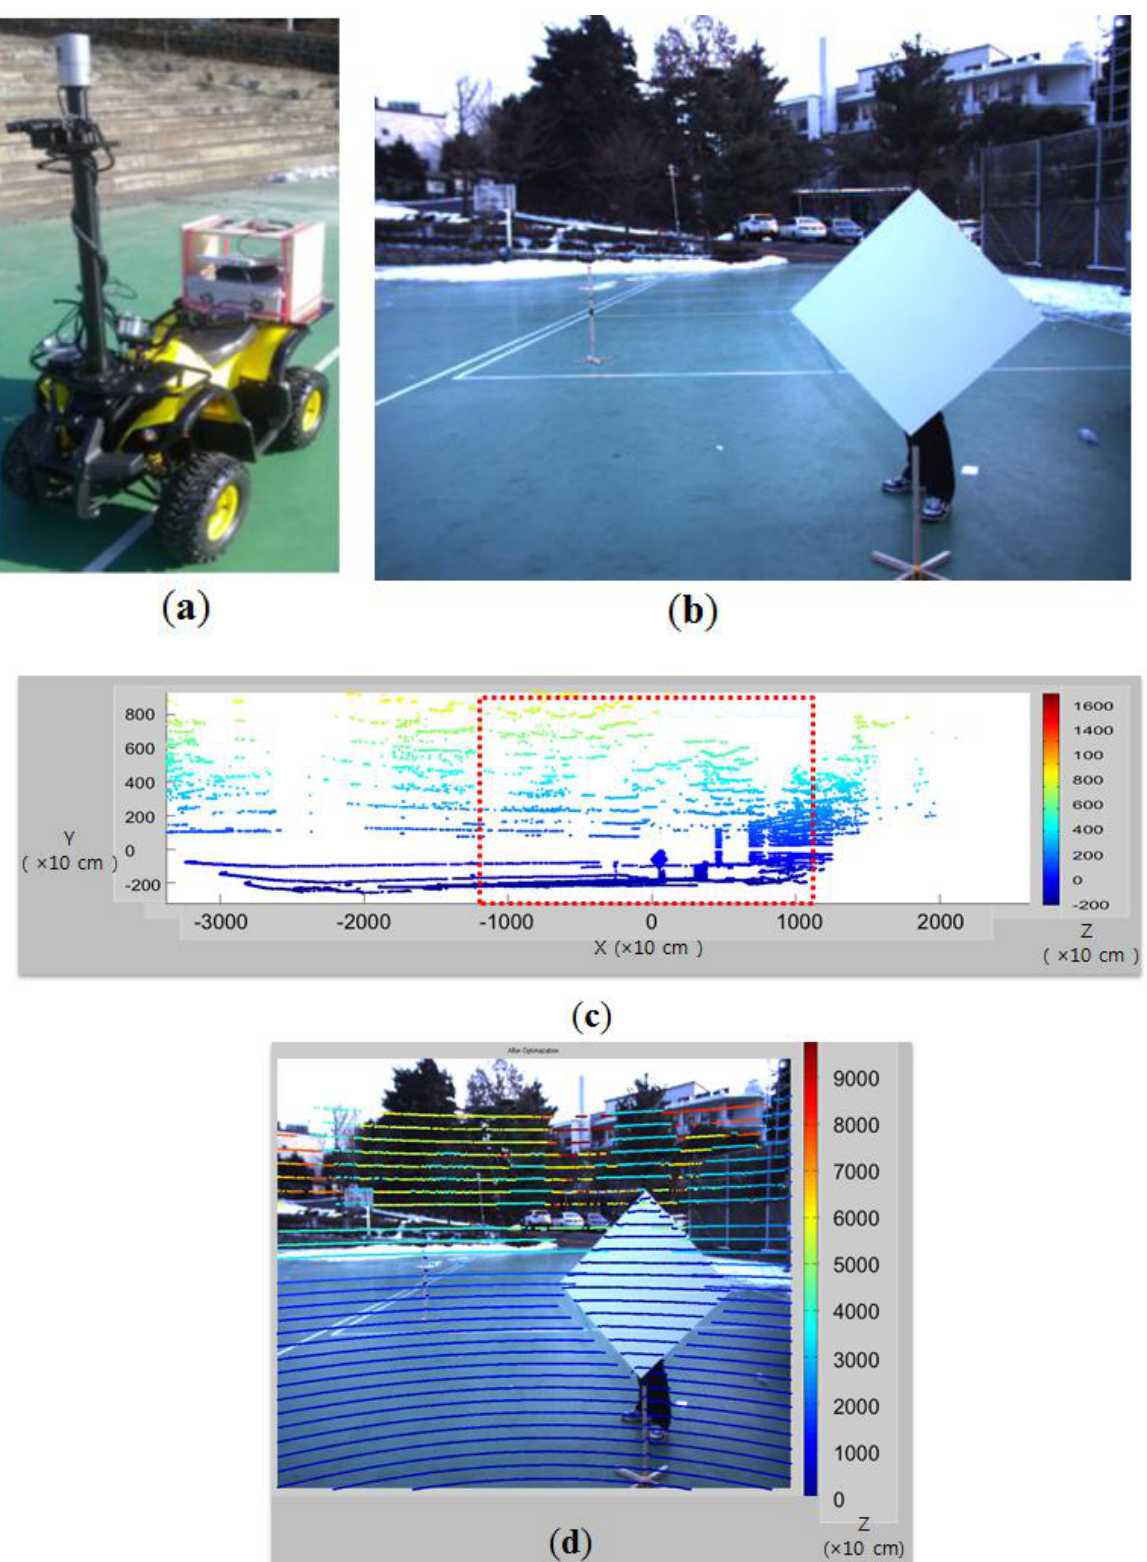
Figure 16. Composition of 3D laser data on the color image by the estimated calibration matrix. ( a ) Cart equipped with camera and Velodyne HDL-32E LIDAR; ( b ) Diamond shaped calibration board; ( c ) 3D point clouds; ( d ) Superimposed color image with the calibrated 3D point clouds (depths are represented by colors on the scan